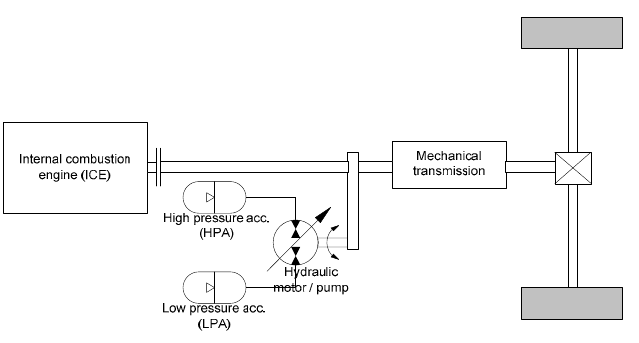
Figure 4. Hybrid hydraulic vehicle (HHV) in parallel configuration.